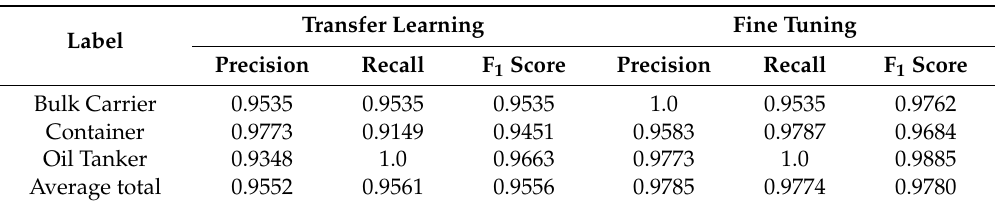
Table 6. Precision, recall, and F 1 score of the model trained via transfer leaning and fine tuning on validation dataset.